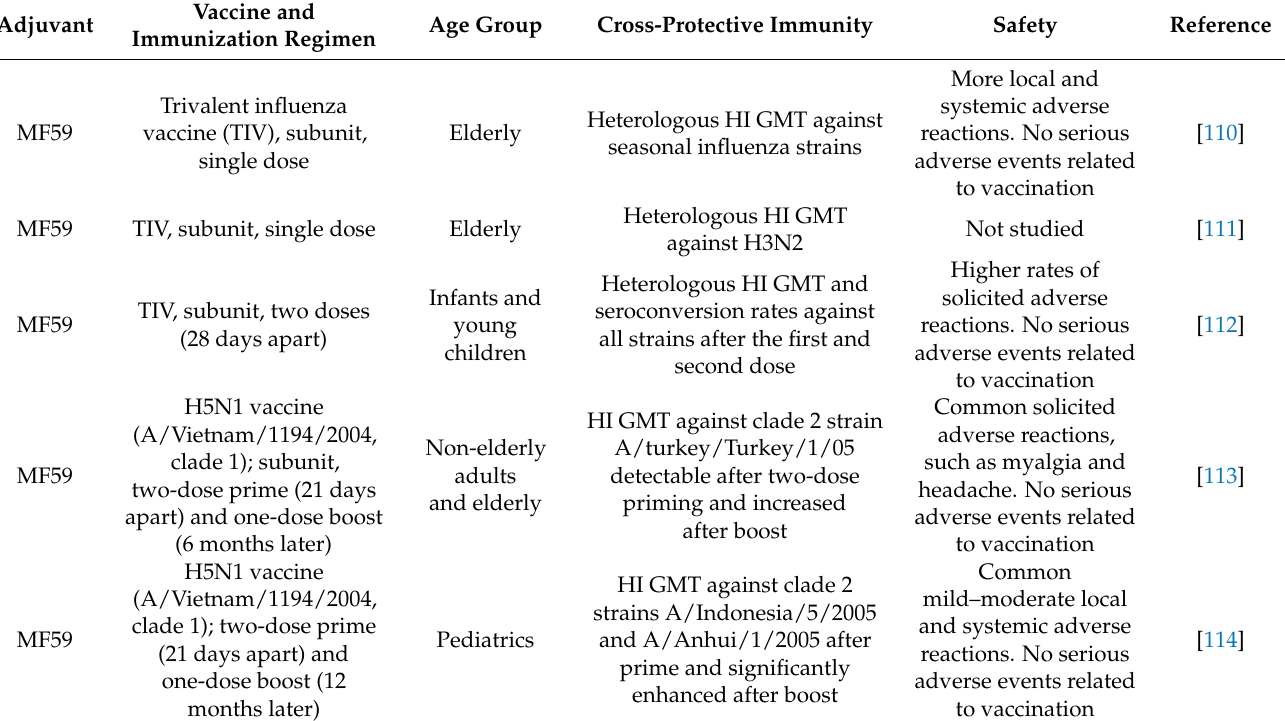
Table 3. Licensed adjuvants assist influenza vaccines to induce cross-protective immunity in human subjects.